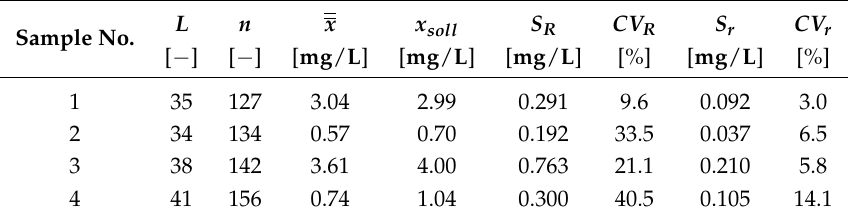
Table 1. Data of inter-laboratory trials published in ISO 9377-2 [30]. Sample